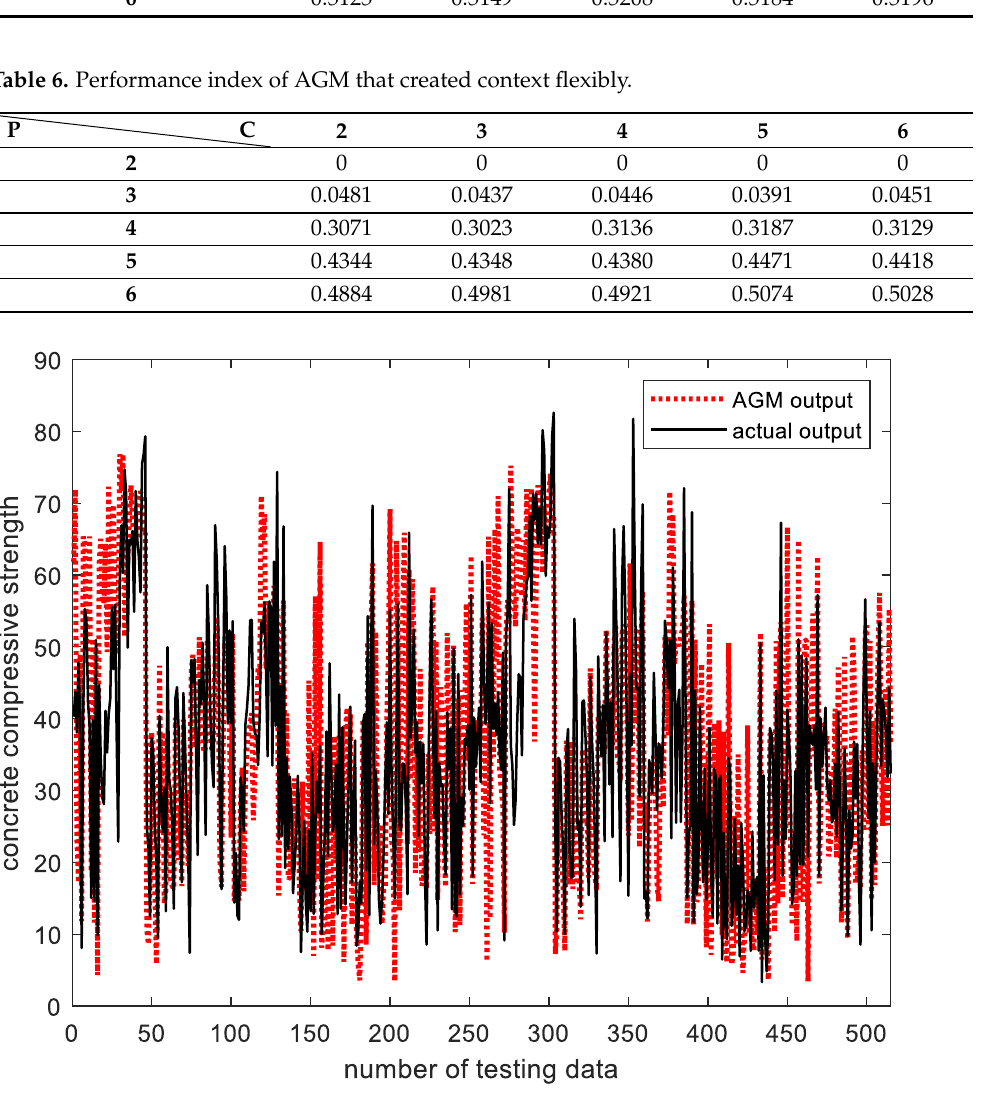
Figure 20. Comparison of the output value of the existing AGM with the actual output value (context is created equally, the number of contexts = 6, the number of clusters = 6).